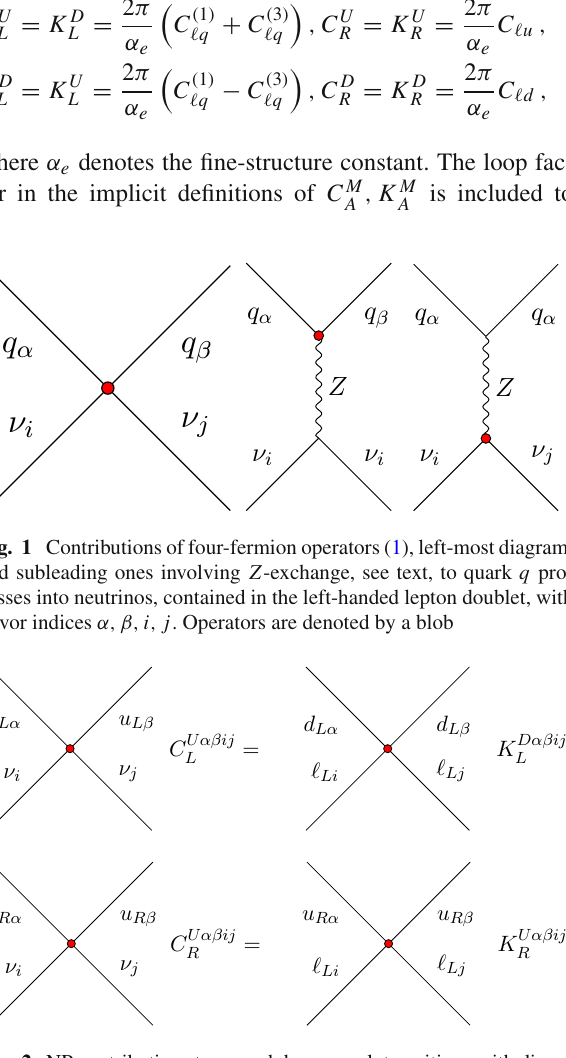
Fig. 2 NP contributions to up and down quark transitions with dineu- trinos C U and dileptons K D and K U , from the operators (1) in the L L , R R fermions’ flavor basis, with flavor indices α,β, i , j . The SU ( 2 ) L -based relation between neutrino and charged lepton operators is exploited in (2) in the mass eigenstate